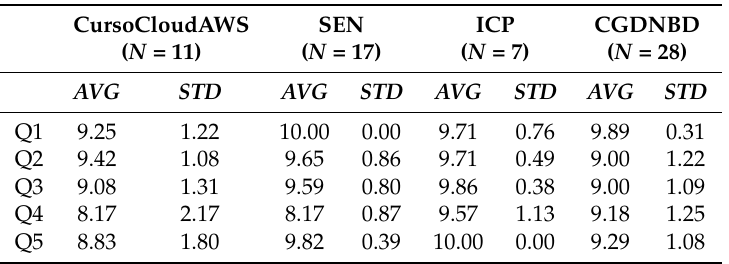
Table 2. Results of the satisfaction questionnaire with CloudTrail-Tracker disaggregated by subject ( N stands for the number of students that filled in the questionnaire for each subject, AVG stands for average and STD stands for standard deviation).